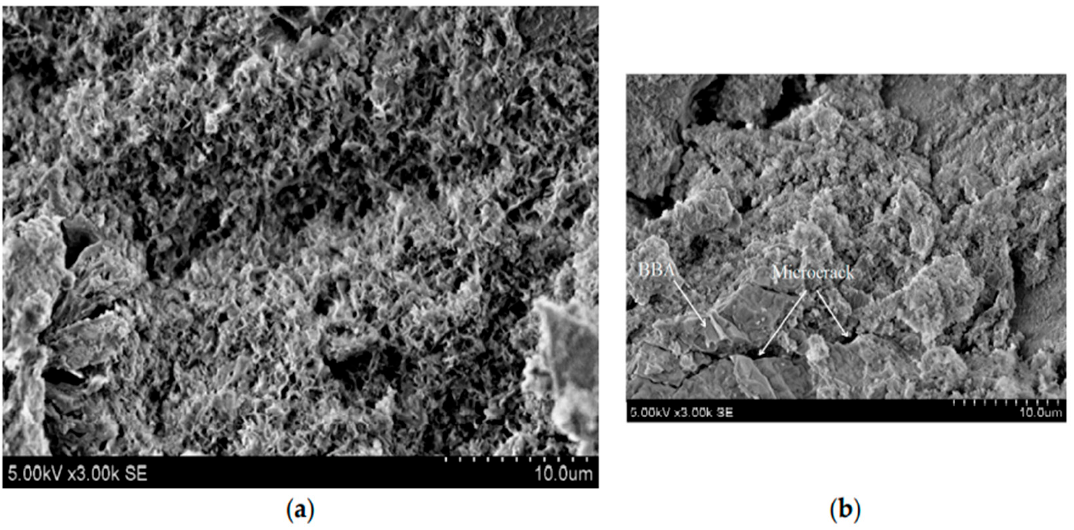
Figure 17. Microstructure of alkali-activated biomass bottom ash-phosphogypsum samples [98]. ( a ) PG 15-3; ( b ) PGWG 15-3.